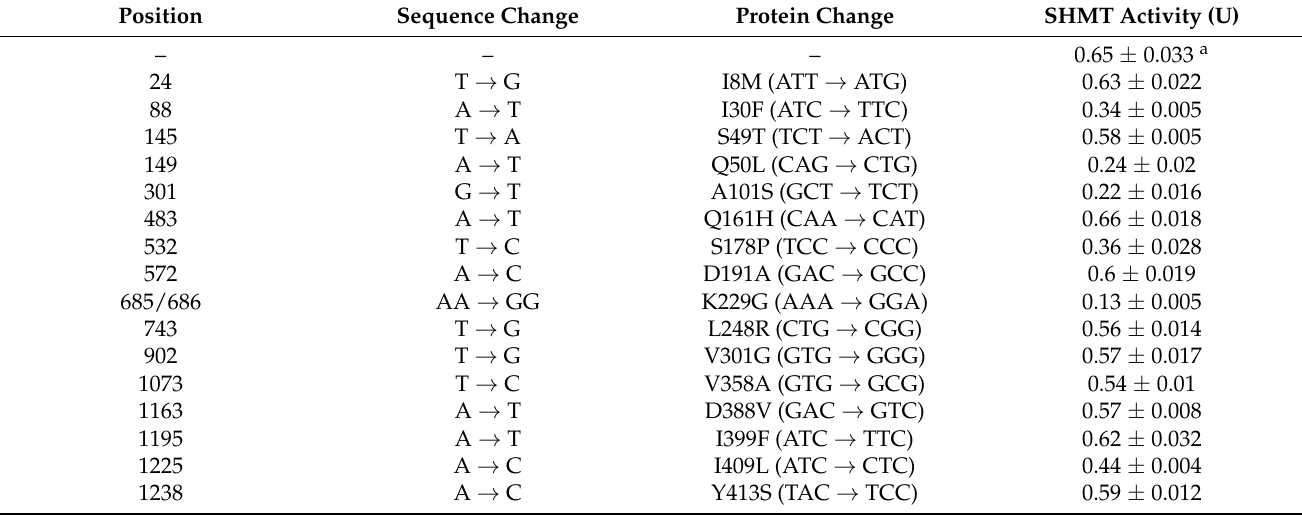
Table 4. The SHMT activity of various mutants.